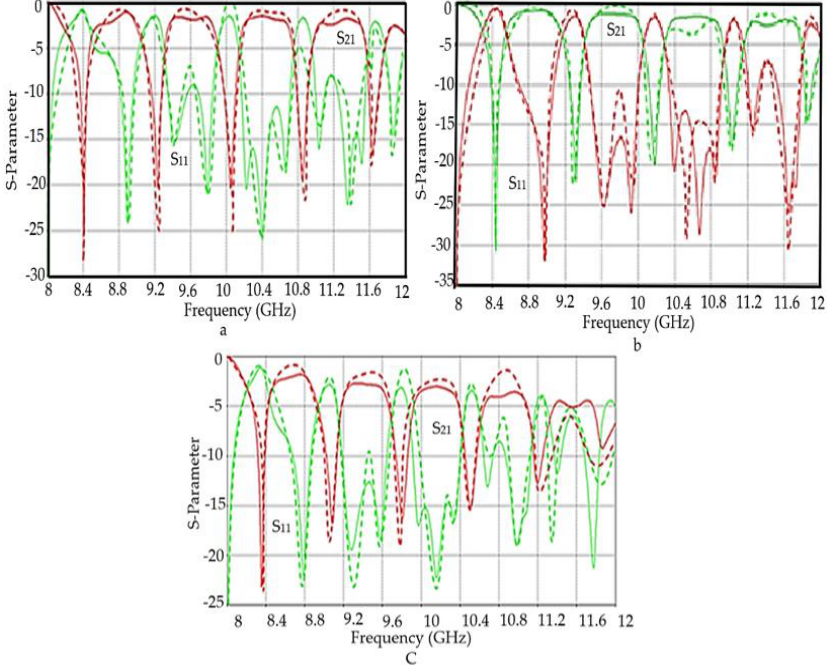
Figure 11. The S-parameters of ( a ) OPEFF / PCL, ( b ) NiO / PCL, and ( c ) OPEFF / NiO / PCL obtained by microstrip T-Junctions connected to VNA.